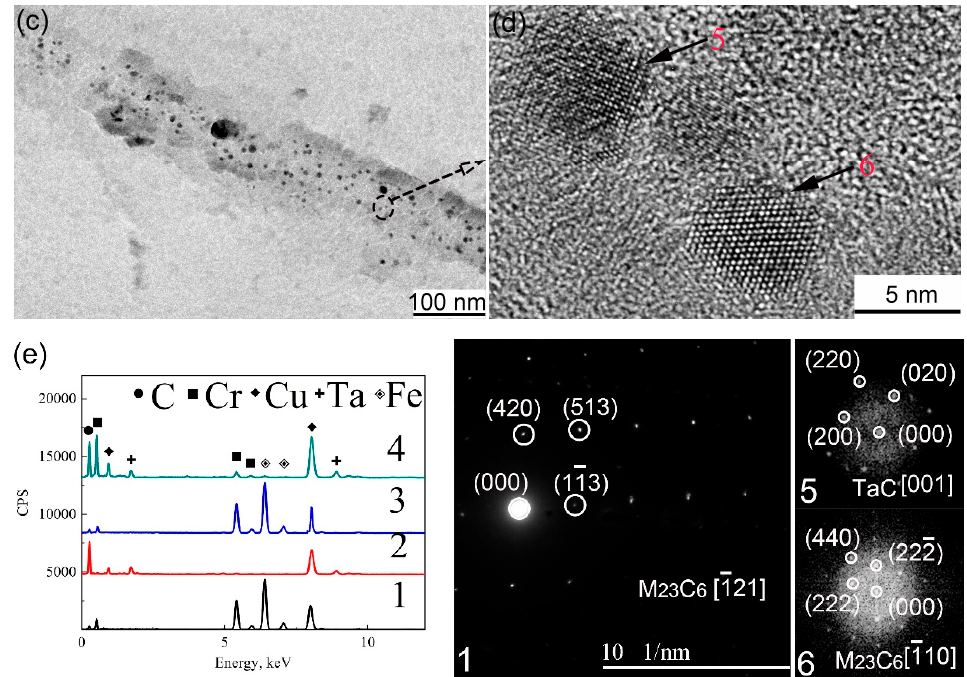
Figure 11. Secondary phases in the MP steel: ( a – c ) carbides distributed along grain boundary; ( d ) high resolution transmission electron microscope (HRTEM) image of nano-sized carbide; ( e ) EDS, SAED, and fast fourier transform (FFT) patterns of the marked